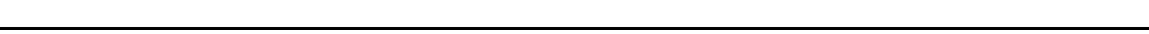
Fig. 5 SIRT5 supports colorectal cancer growth by promoting glutamine metabolism via increased GLUD1 enzyme activity. a A diagram showing the enzymes involved in glutamine metabolism and the inhibitors used in this study. b Expression of GLUD1, GOT1/2, PSAT1, GPT2, and GLS (including kidney- type glutaminase (KGA isoform), and glutaminase C (GAC isoform)) upon SIRT5 knockdown. c GLUD1 enzyme activity was determined upon SIRT5 knockdown in HCT116 and LoVo cells. Left, representative images ( n = 3). Right, quanti fi cation of GLUD1 activity. GLUD1 inhibitor epigallocatechin gallate (EGCG; 20 μ M) was used as a positive control. d – f GLUD1 ( d ), GLS ( e ), and GOT2 ( f ) enzyme activities were determined in HCT116 and LoVo cells stably expressing the control vector, SIRT5 WT, or SIRT5 H158Y, respectively; n = 3. g Proliferation rate of HCT116 and LoVo cells stably expressing the